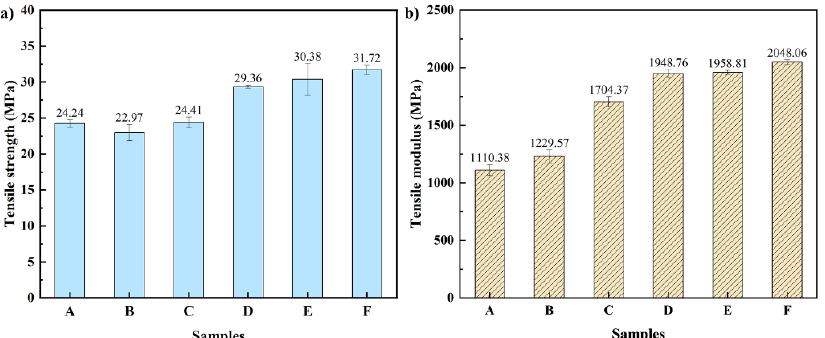
Figure 4. ( a ) Tensile strength and ( b ) tensile modulus of the